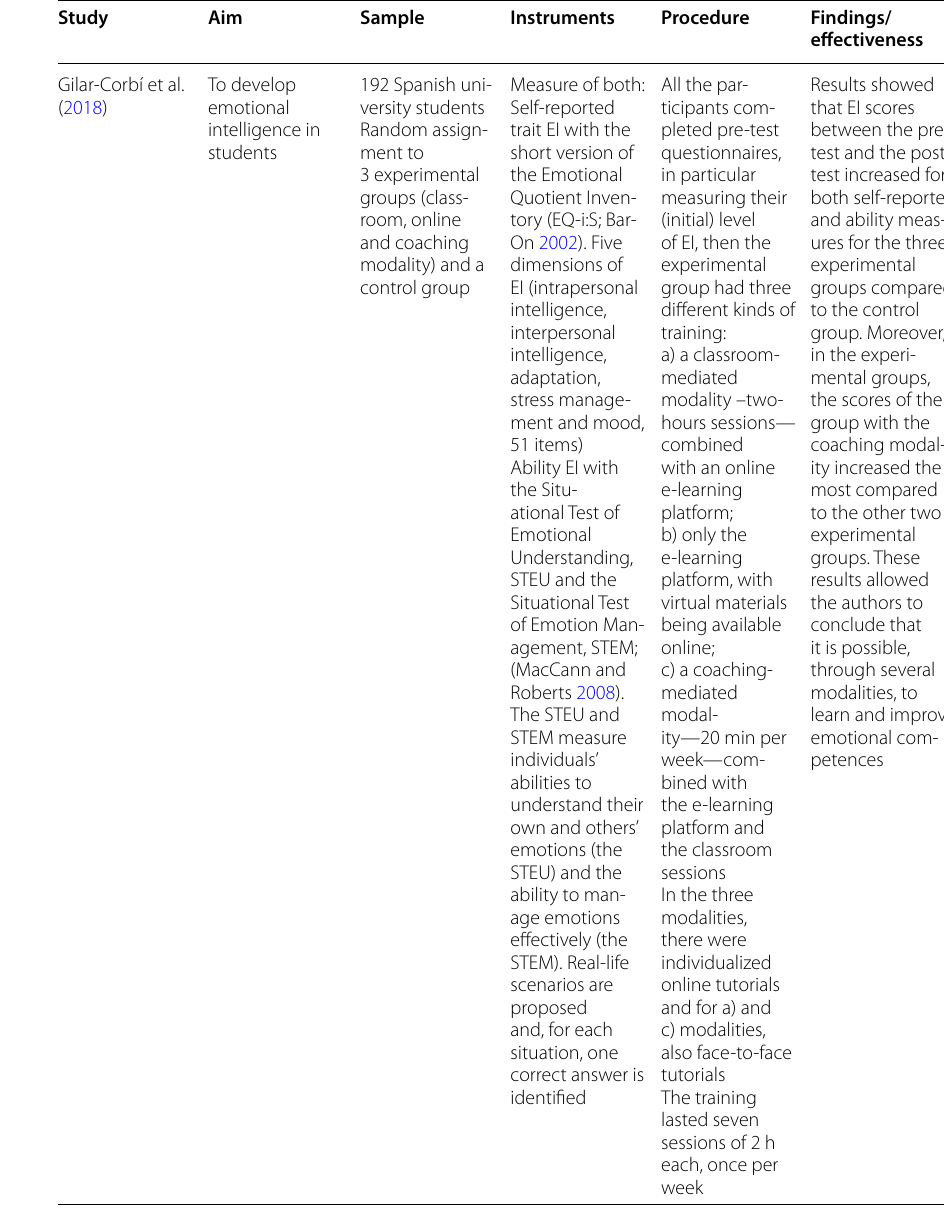
Table 2 Overview of the main characteristics of the studies of Gilar-Corbí et al. (2018) and Jennings et al.